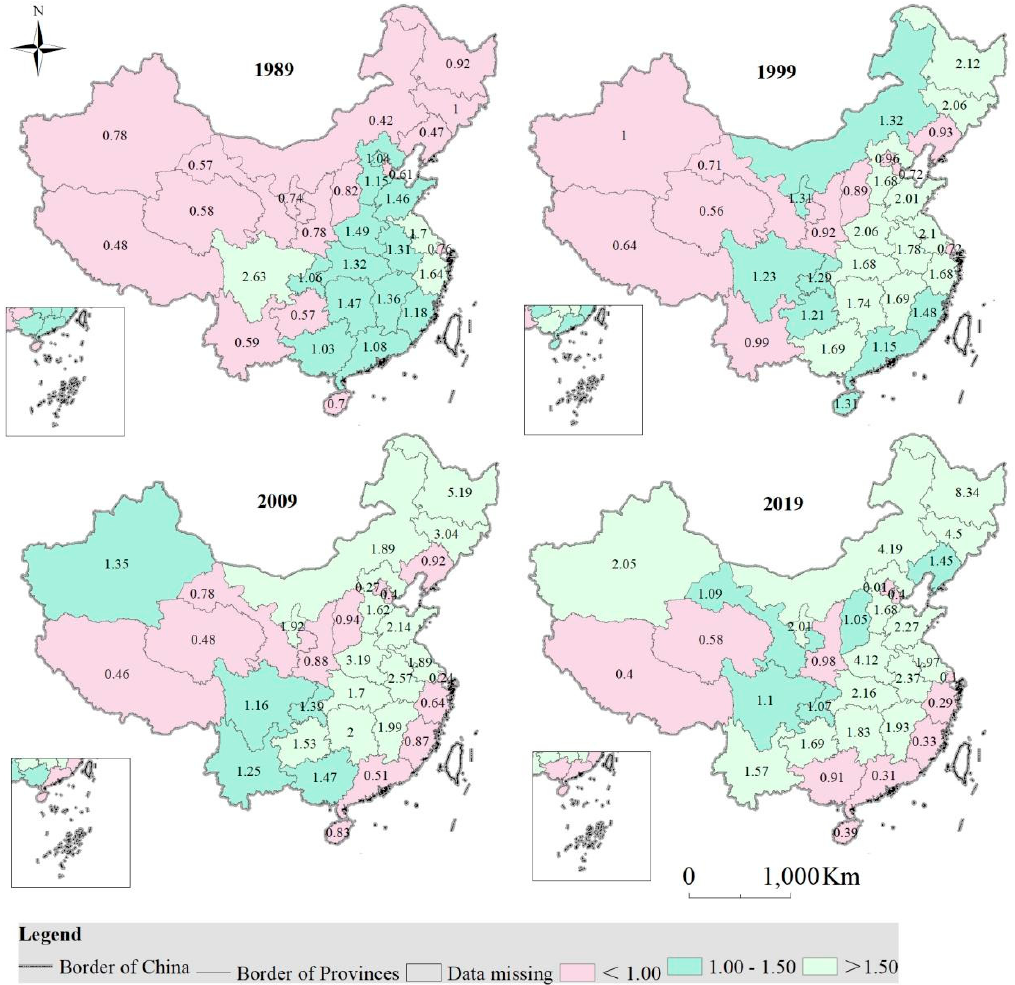
Figure 5. Guarantee rate of cropland in China from 1989 to 2019, and the value (unit: 100%) in the map stands for the guarantee rate in each province.